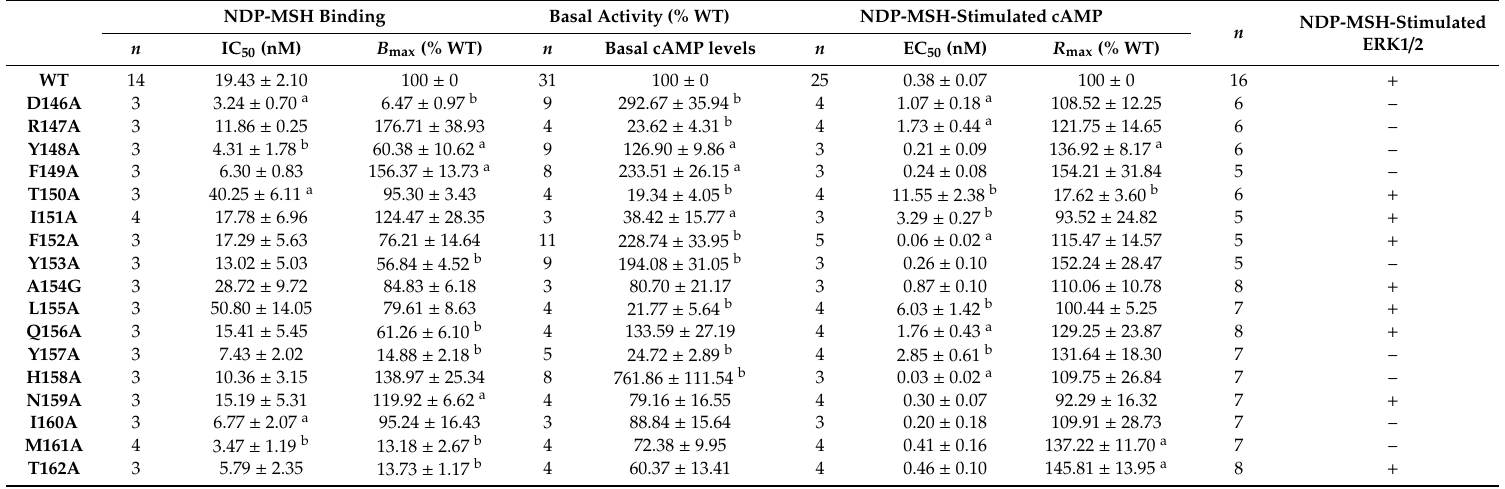
Table 1. The ligand-binding and signaling properties of WT and mutant MC4Rs. Values are expressed as the mean ± standard error of the mean (S.E.M.) of at least three independent experiments. The maximal response ( R max ) of WT MC4R was 1662.19 ± 136.63 pmol cAMP / 10 6 cells with NDP-MSH